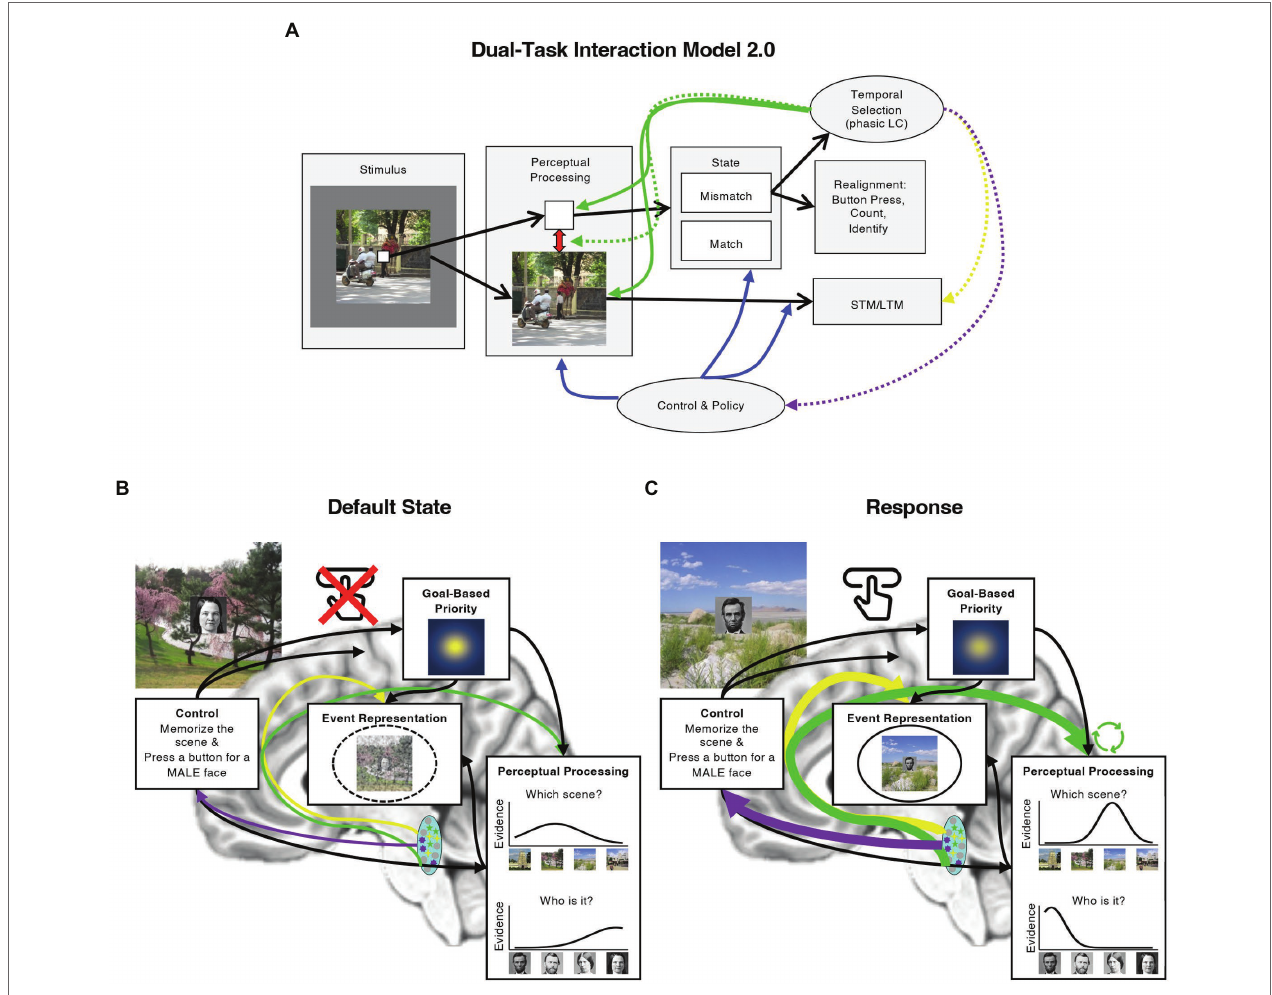
FIGURE 2 | Updating the Dual-Task Interaction Model. (A) Illustration of the original DTI model (Swallow and Jiang, 2013) with several proposed modifications (Dual-Task Interaction Model 2.0). Like the original DTI model, we assume that presenting multiple items at once results in competition among them (red arrow in “Perceptual Processing” box; e.g., Buschman and Kastner, 2015), that control mechanisms instantiate the task by guiding attention and processing in a top-down manner (“Control and Policy” box and arrows leading from it; e.g., Badre and Nee, 2018), that temporal selection facilitates perceptual processing by increasing gain and consequently sensory precision (green arrows to “Perceptual Processing” box), and that this effect is generated by phasic LC activity. We further specify that temporal selection occurs when mismatches between the state of the world and the state of the neurocognitive system (“State” second box from the right) require a response to bring them back into alignment (“Realignment,” far right box) and that these responses may enhance the formation of bound, multi-item representations of items in the MTL (yellow dashed arrow). Computational models further suggest that phasic LC increases competition between attended and unattended items (green dashed arrow; Mather et al., 2016) or promote shifts to new neurocognitive states by briefly weakening top-down influences (purple dashed arrow; Shine et al., 2016). We note that the former possibility is based on paradigms with different timings and that there is currently little evidence to support the latter possibility. We include it for completeness. (B) An example of the default state of the system when the task is to both memorize scenes and press a button for male, but not female faces. Once a continuous encoding dual-task has been started, the default state of the system is to prioritize the images and faces (illustrated by the “Goal-Based Priority” box), and to withhold a button press until there is enough perceptual evidence that a male face has been presented. Perceptual processing results in image specific evidence for both faces and scenes, and these are bound to each other and their context in the MTL. (C) An example of the state of the system when a response must be generated. Under these conditions, we propose that phasic LC activity (blue oval) increases sensory precision in perceptual areas (green arrow; indicated by the taller, narrower evidence curve). These effects could be greater for prioritized information (green circular arrows). The result is richer sources of information for episodic encoding (“Event Representation”) in conjunction with direct enhancements to the formation of bound event memories (solid circle; it is dashed in panel B ). It may also be possible that phasic LC activity disrupts the influence of control representations, weakening top-down biases in stimulus processing (illustrated by the weaker spotlight in the “Goal-Based Priority” box). Each of these effects could arise from LC cellular ensembles that project to different regions of the brain, regardless of whether they are independently or globally activated (illustrated with differently colored cells in the LC; see “ Modular circuitry and function in the LC ”). Image attributions: As in Figure 1 , additionally, Ulysses Grant image has no restrictions from https:// www.loc.gov/pictures/item/2017896375/, and Julie Grant image CC0 from